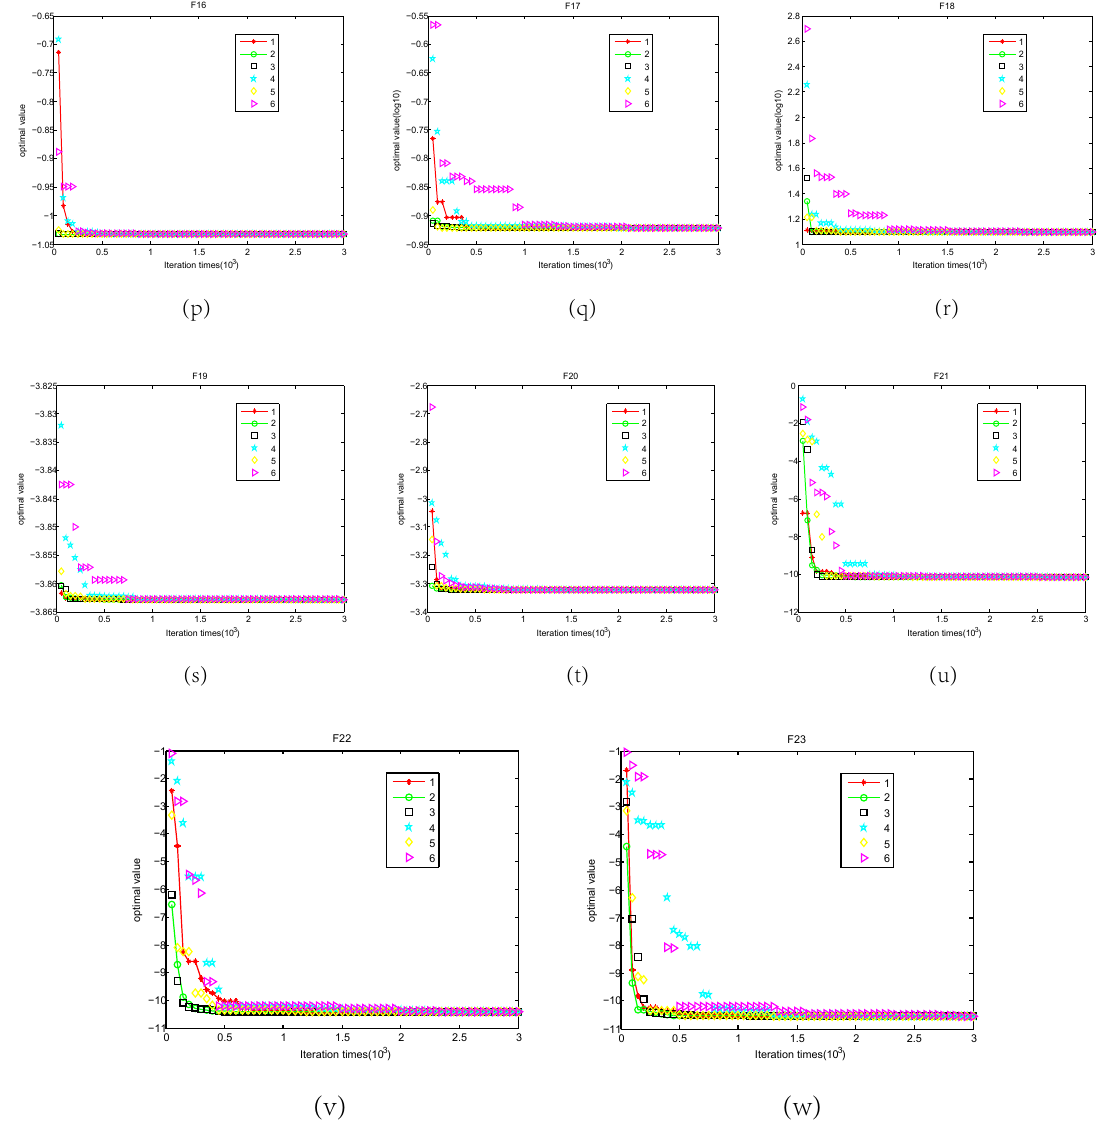
Figure 2. Convergence curves on test functions F1–F23 for different a values, where ( a – w ) indicate the convergence curves on the functions F1–F23